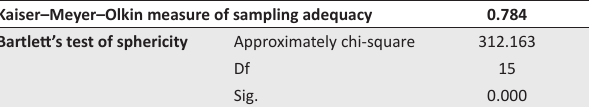
TABLE 4: Kaiser–Meyer–Olkin and Bartlett’s test (Section